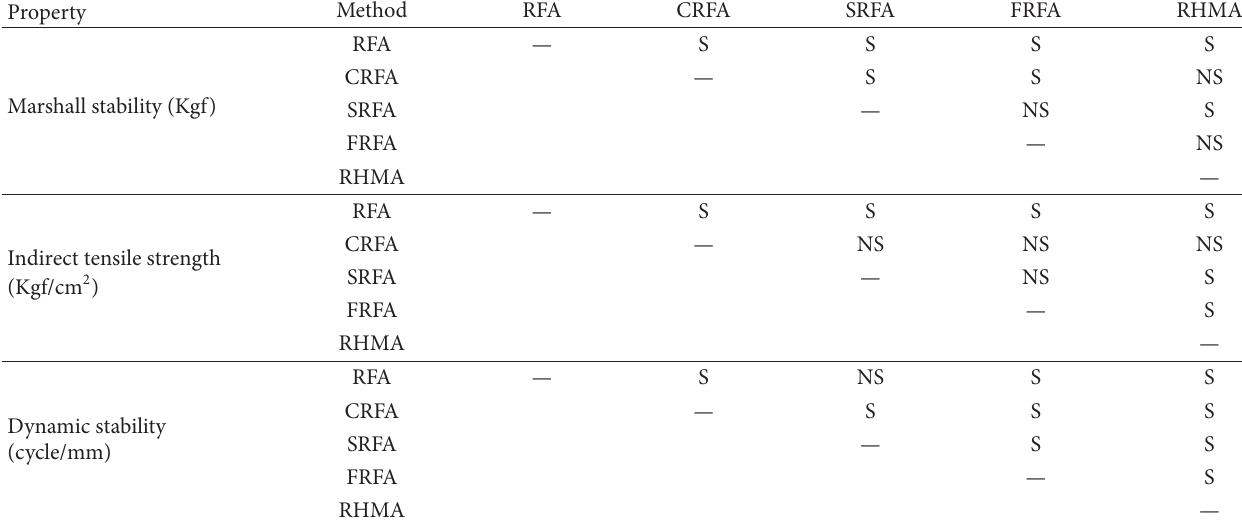
Table 3: Summary of 𝑡 -test results for the three properties.